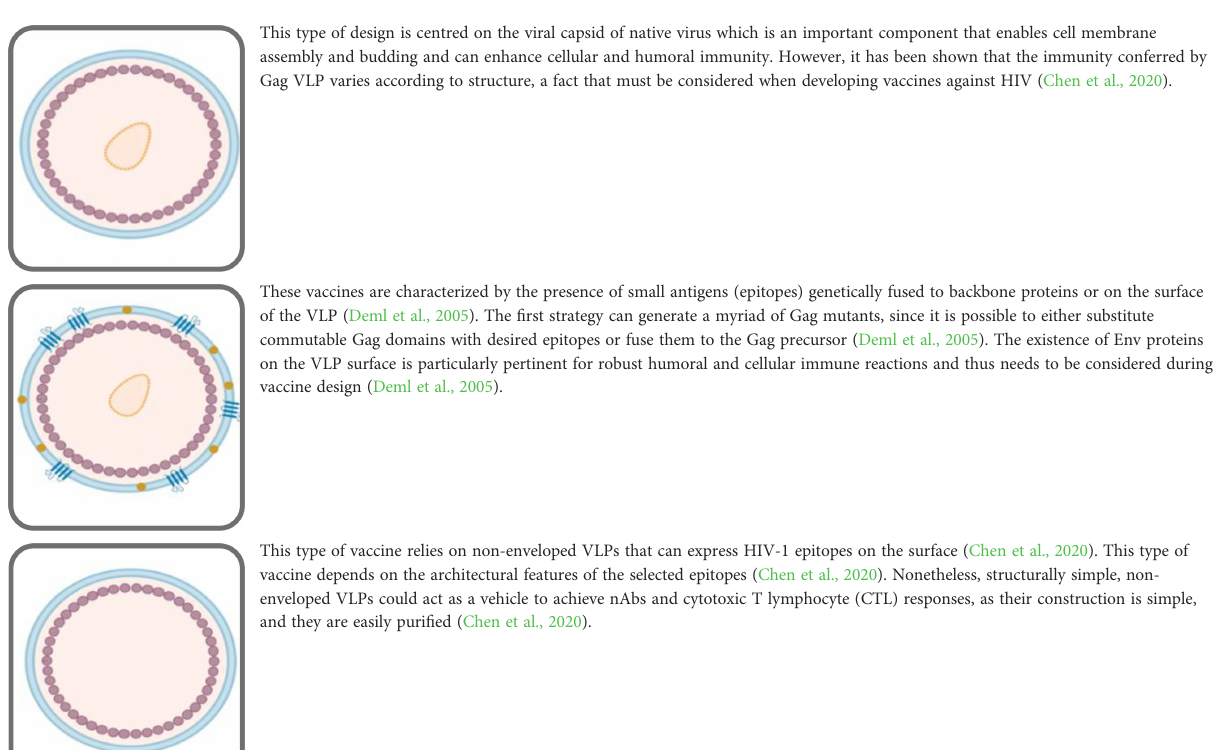
TABLE 2 Comparison of structural features and functional versatility of VLPs corresponding to VLP-based HIV-1 vaccine design (Rovinski et al., 1995; Wagner et al., 1996; Deml et al., 1997; Buonaguro et al., 2002; Deml et al., 2005; Tagliamonte et al., 2011; Pastori et al., 2012; Zhai et al., 2013; Chen et al.,